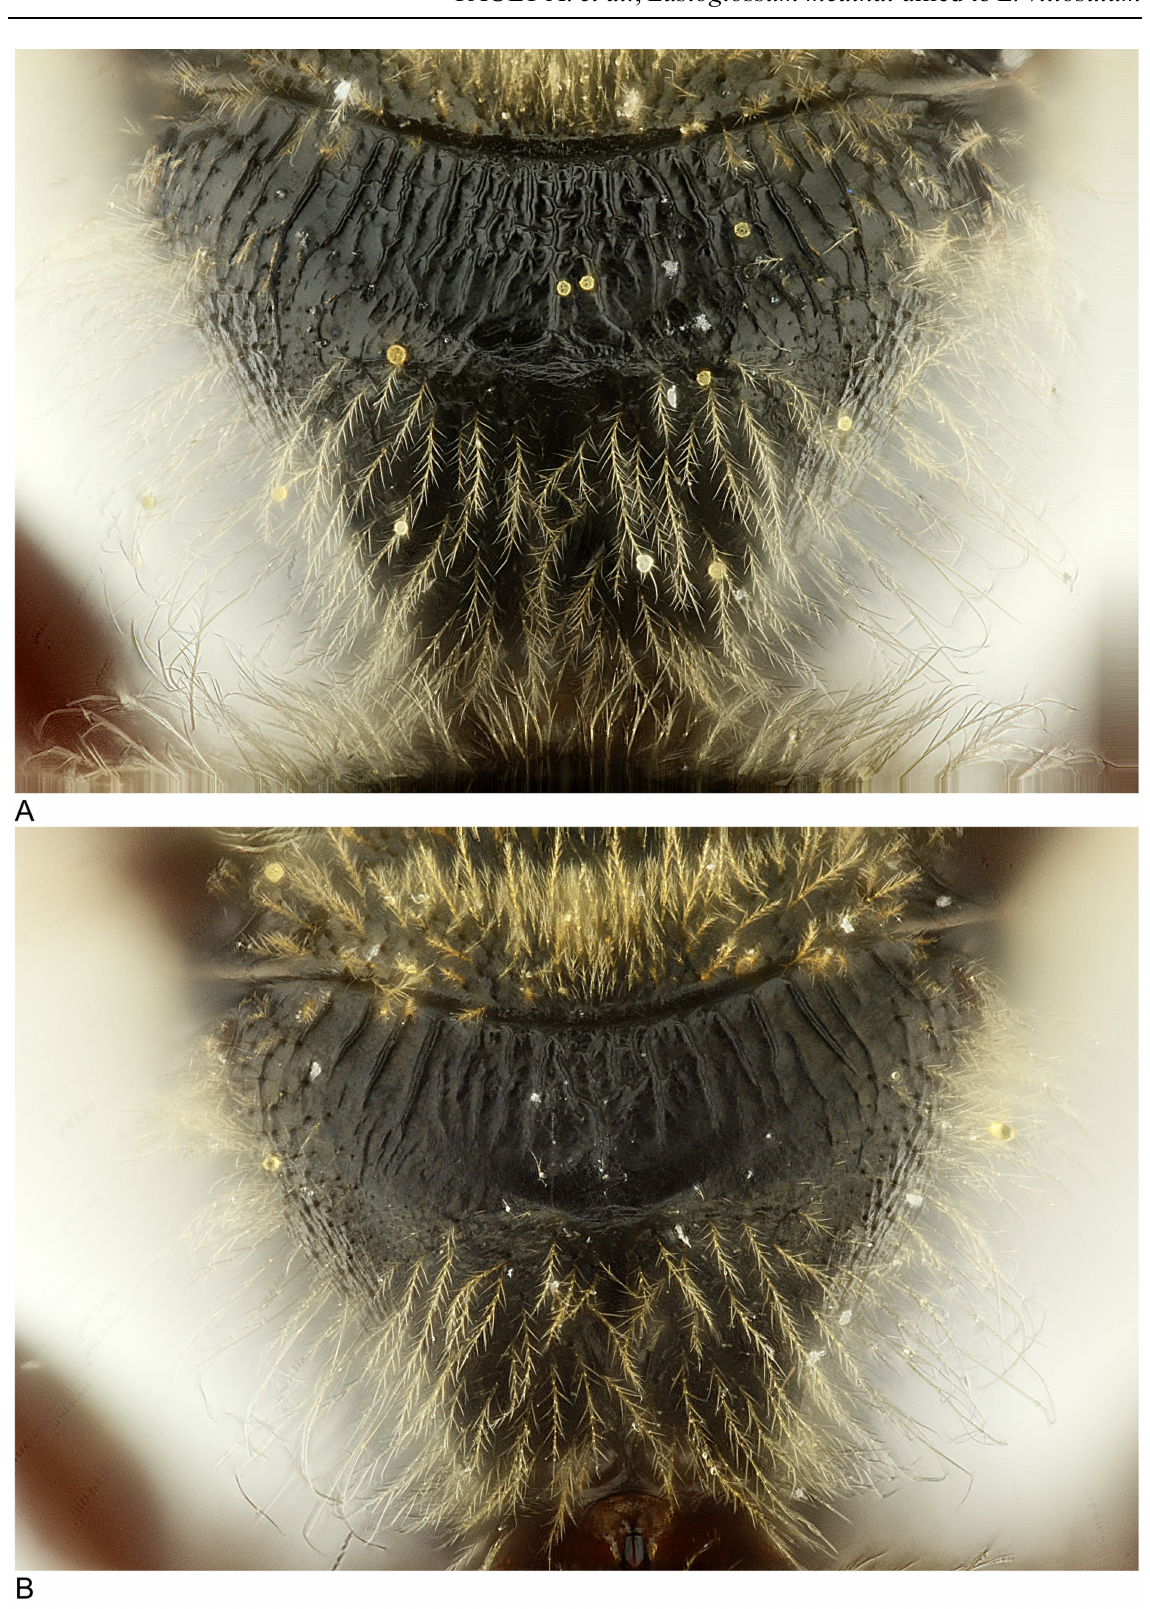
Fig. 17. Propodeum sculpture of females. A . Lasioglossum medinai (Vachal, 1895) (France: Uchaux). B . L. villosulum (Kirby,